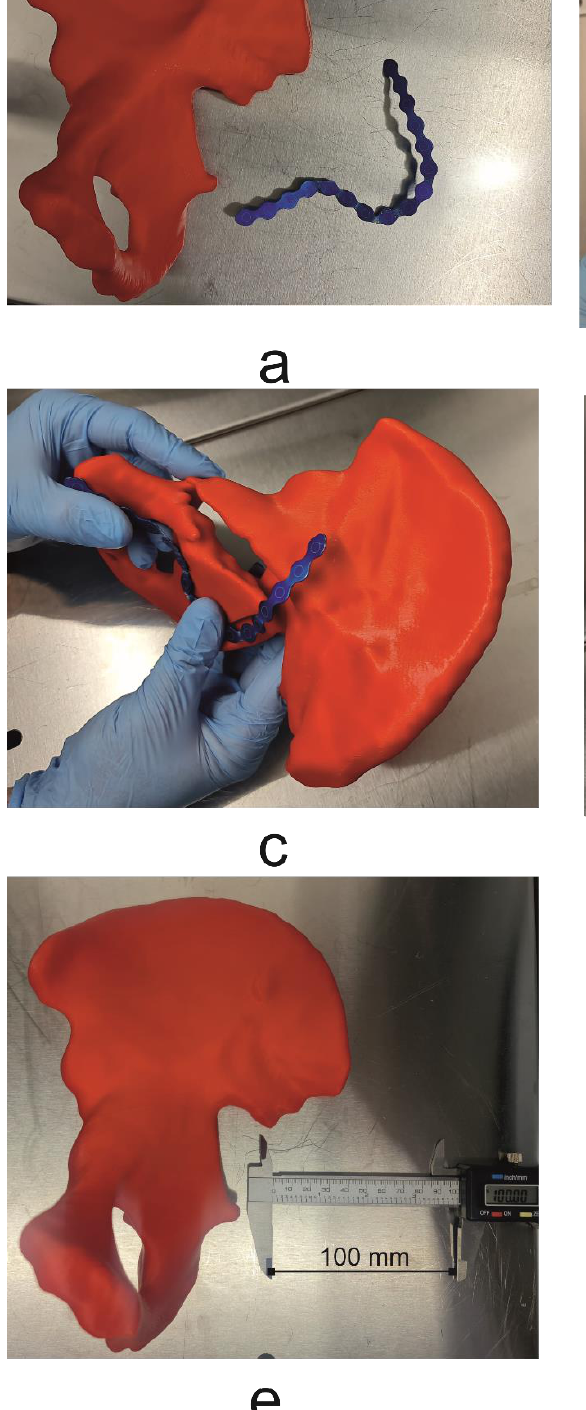
Figure 4 . ( a ) Mirrored uninjured hemipelvis with bending template, ( b , c ) process of shaping and fitting bending template to the patient’s unique anatomy, ( d ) final shaped bending template, ( e ) 3D model with scale bar (100 mm).